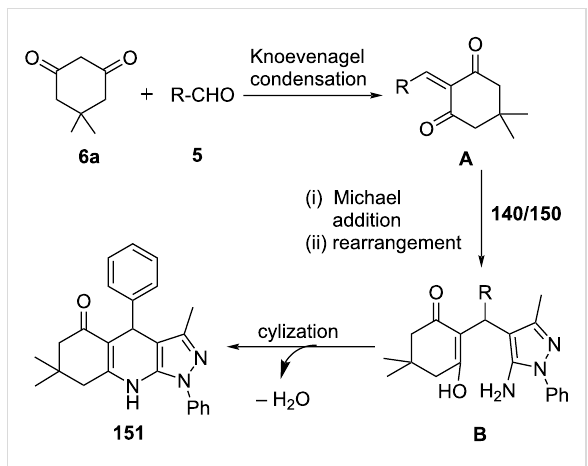
Scheme 63: Plausible mechanism for pyrazoloquinoline